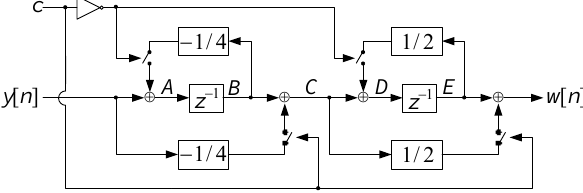
Figure 10. The time diagram of control signal c in the proposed 1 ‐ D inverse 5/3 filter.